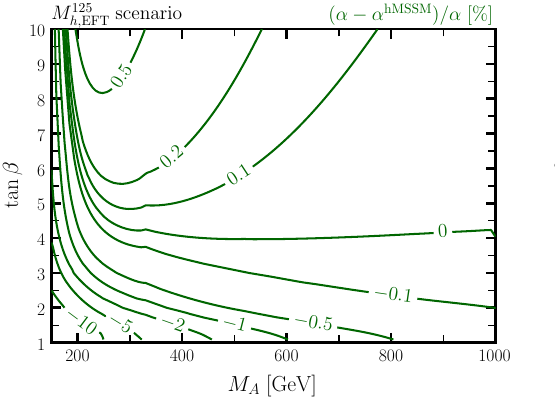
Fig. 12 Left :Relativedifferenceinthepredictionofthe(effective) CP - even Higgs-boson mixing angle α between the M 125 hMSSM approach in %. Right : Relative difference in the prediction of